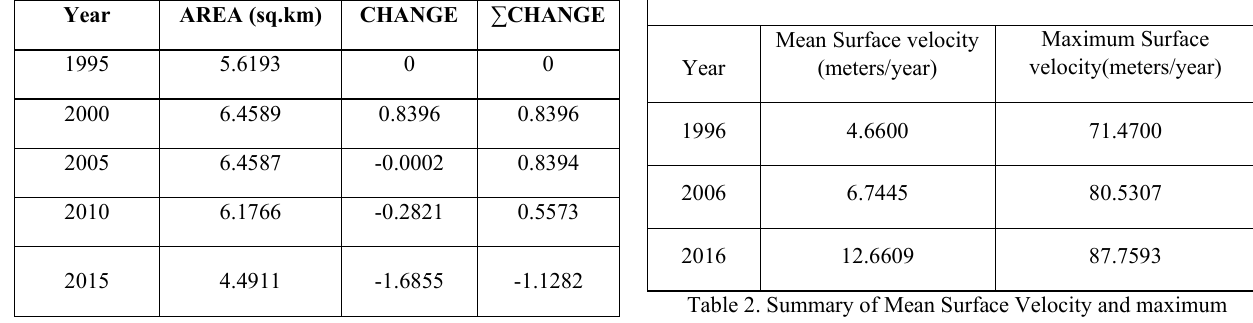
Table 1. Summary of change in ice area of Glacier.